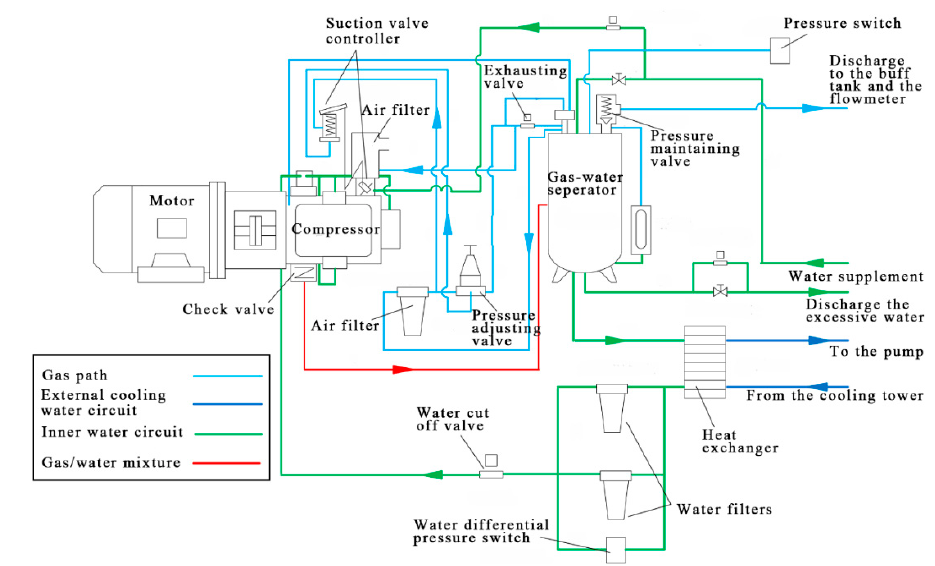
Figure 1. A schematic view of a SSC.